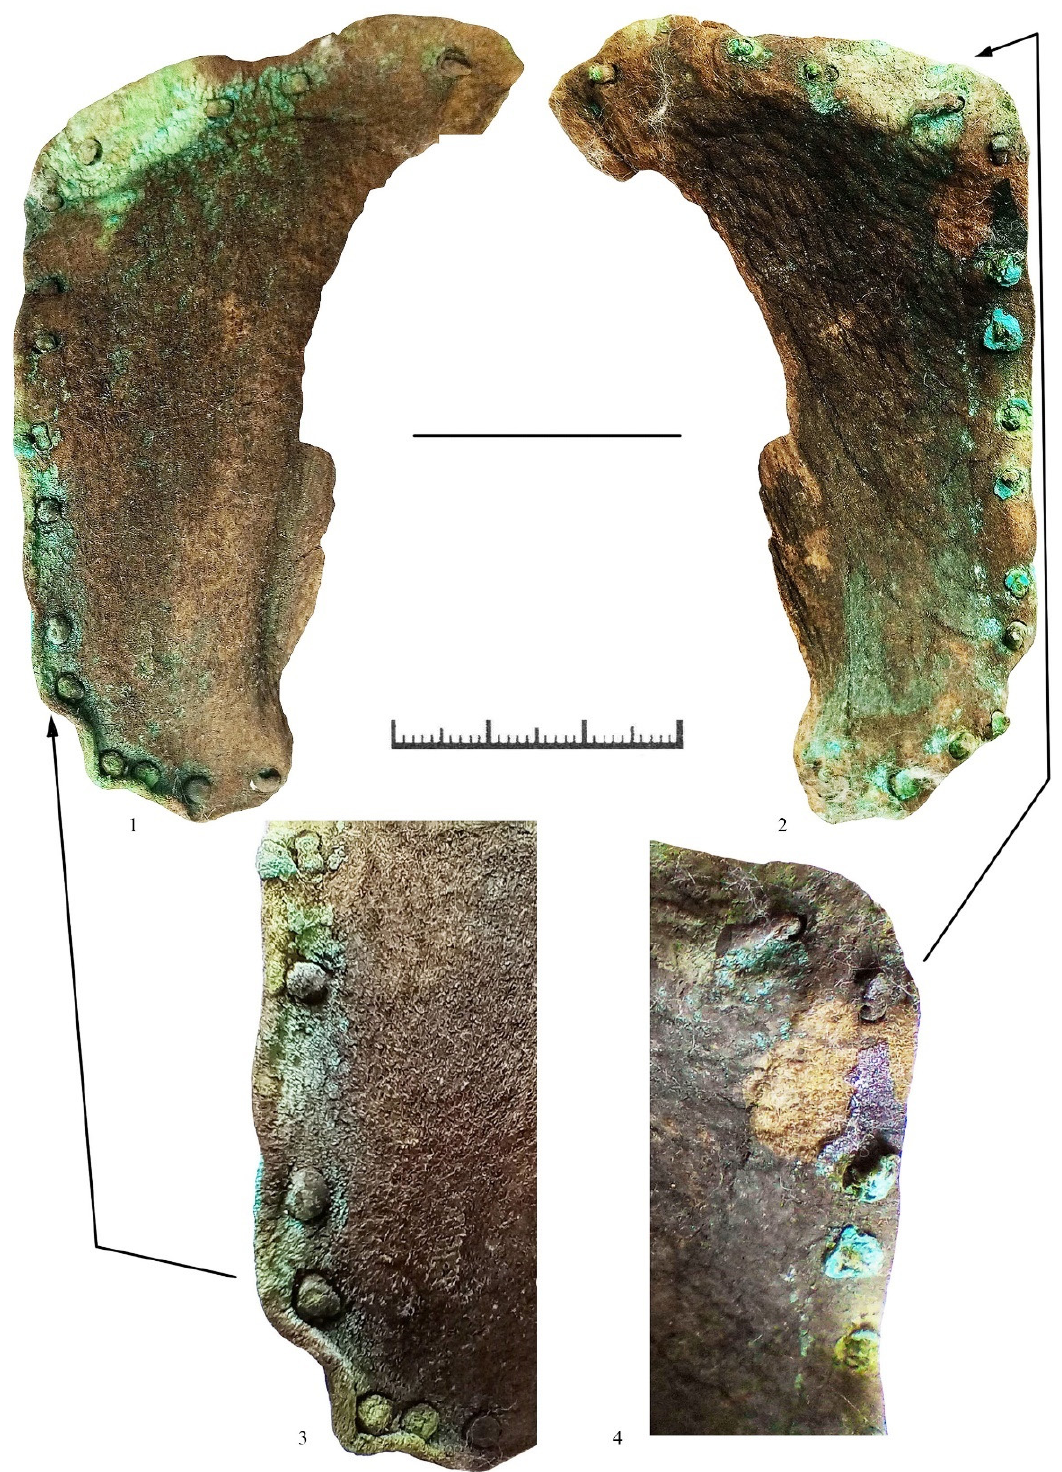
Figure 9. Vodoslavka Barrow 6 Burials 1–2. The right greave. Leather overlay that covered the lateral opening. (1)—the side that adhered to the warrior’s leg; (2)—the side that covered the hole and adjoined the greaves; (3)—detail of (1); (4)—detail of (2) (photograph М . Daragan). 2. Three fragments from the bottom edge of the greave (Figure 10(1)). The restored section has a horizontal arch-shaped curve. Along the edge, small holes for sewing on the lining were pierced into the metal from the inside. They measure 0.3 cm in diameter and are placed at 0.8–1.0 cm intervals from each other. Smoothed burrs around the holes re- main visible on the exterior. The length of the fragment is 9.5 cm.